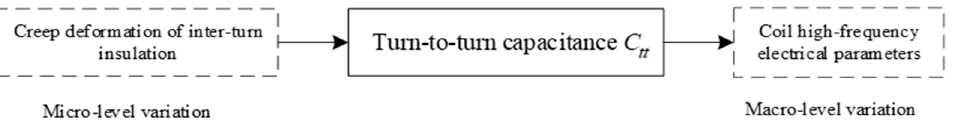
Figure 7. E ff ect of creep deformation of inter-turn insulation material on coil high-frequency parameters response.